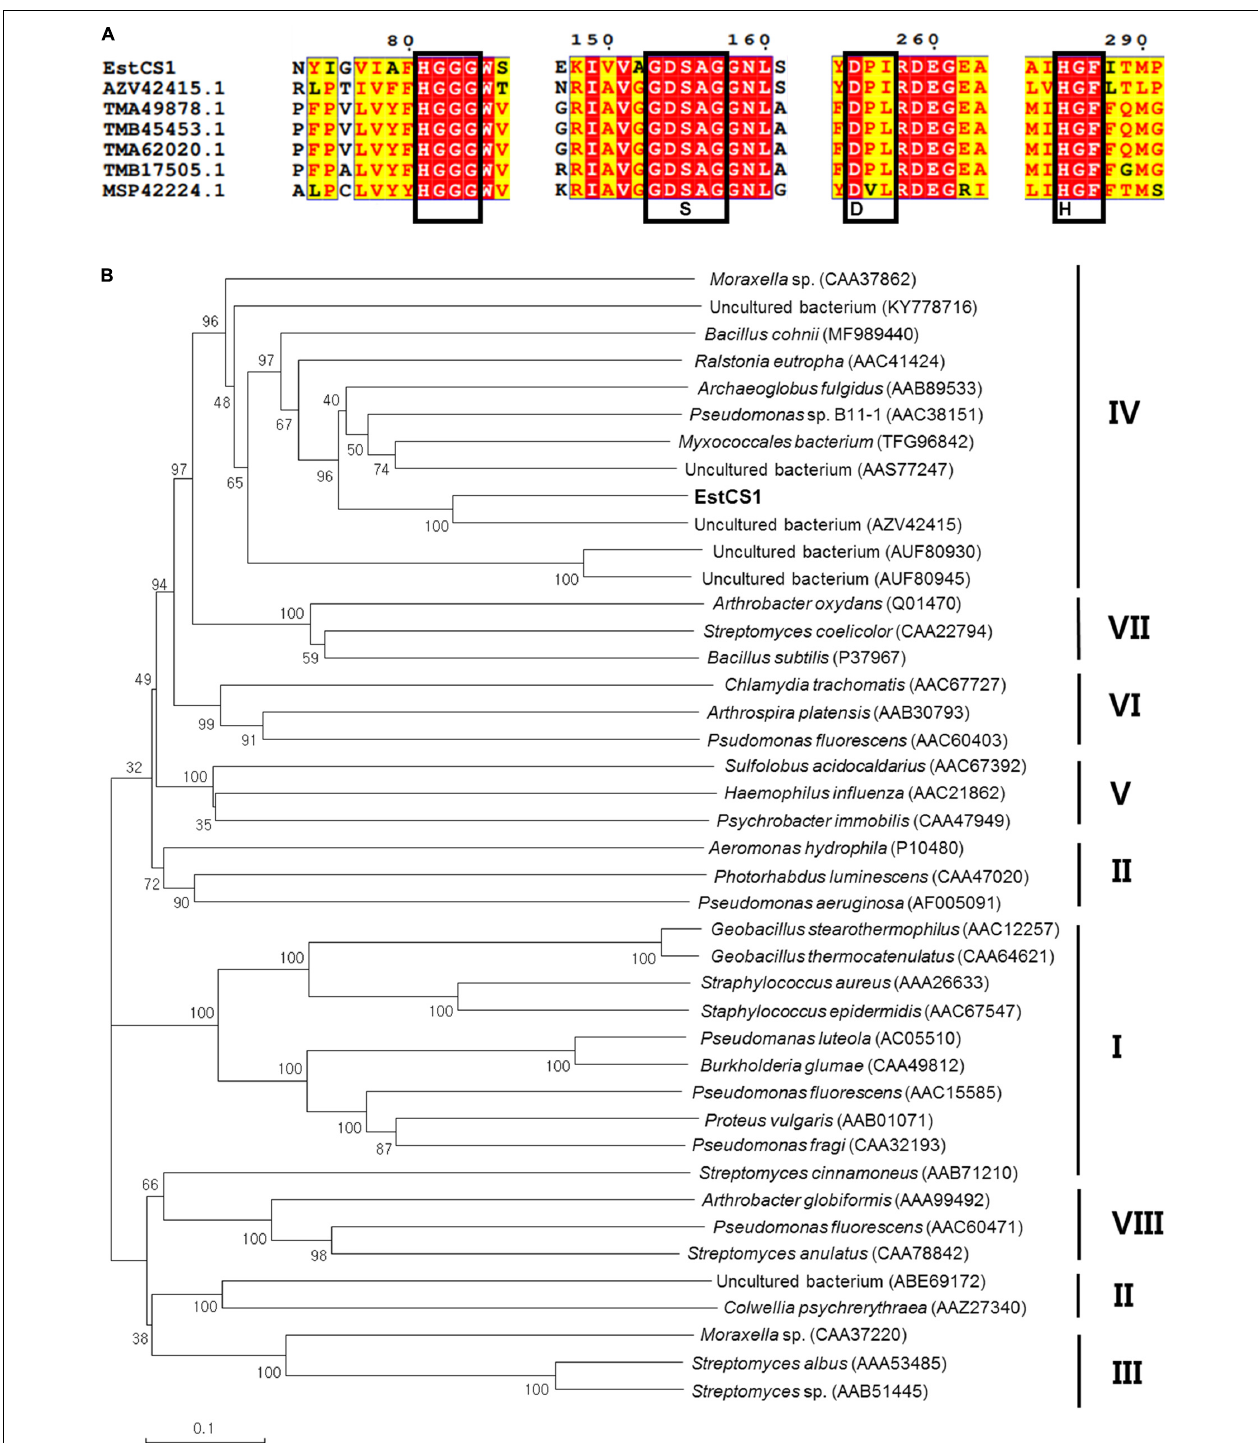
FIGURE 1 | (A) Multiple amino acid sequence alignments of EstCS1 and its homologs. AEM45131.1, hypothetical protein (uncultured organism); AAS77247, esterase lipase (uncultured bacterium); ADR31550, EST1 (uncultured bacterium); ABQ11269, lipase esterase (uncultured bacterium); and ABQ11269, lipase esterase (uncultured bacterium). (B) Phylogenetic tree based on amino acid sequence of EstCS1 and closely related proteins. The phylogenetic tree illustrates a neighbor-joining method using MEGA4. The numbers at the node indicate bootstrap percentages of 1,000 replicates. The units at the bottom of the tree indicate the number of substitution events. Except for EstCS1, the protein sequences for previously identified families of bacterial lipolytic enzymes were retrieved from GenBank (http://www.ncbi.nlm.nih.gov).